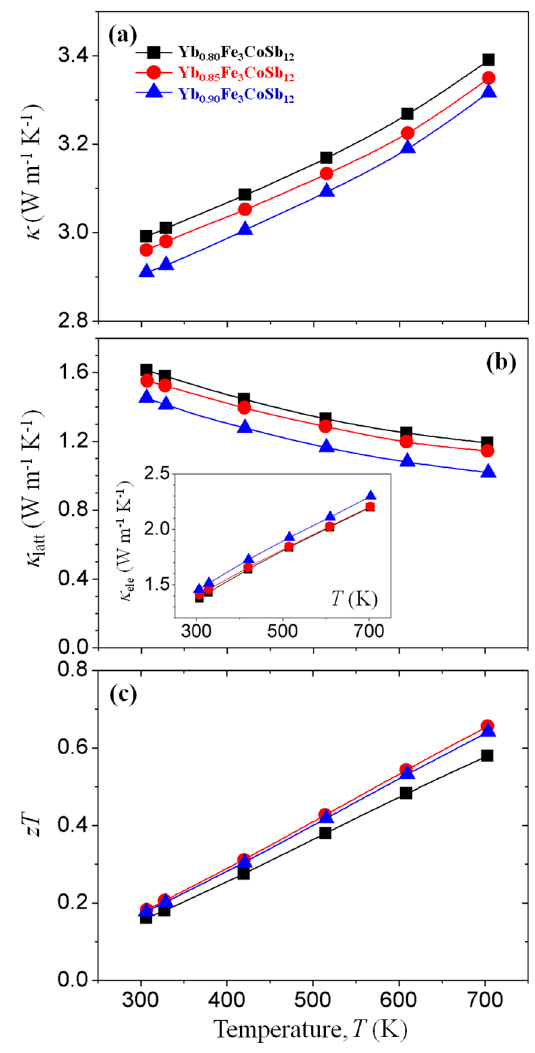
Figure 4. Temperature dependences of ( a ) total thermal conductivity ( κ ) and ( b ) lattice thermal conductivity ( κ lat ) for Yb x Fe 3 CoSb 12 (x = 0.80, 0.85, 0.90) bulks. Electronic contribution for the thermal conduction ( κ ele ) is shown in the inset of ( b ). ( c ) Temperature dependences of dimensionless figure of merit ( zT ) for Yb x Fe 3 CoSb 12 (x = 0.80, 0.85, 0.90) bulks.